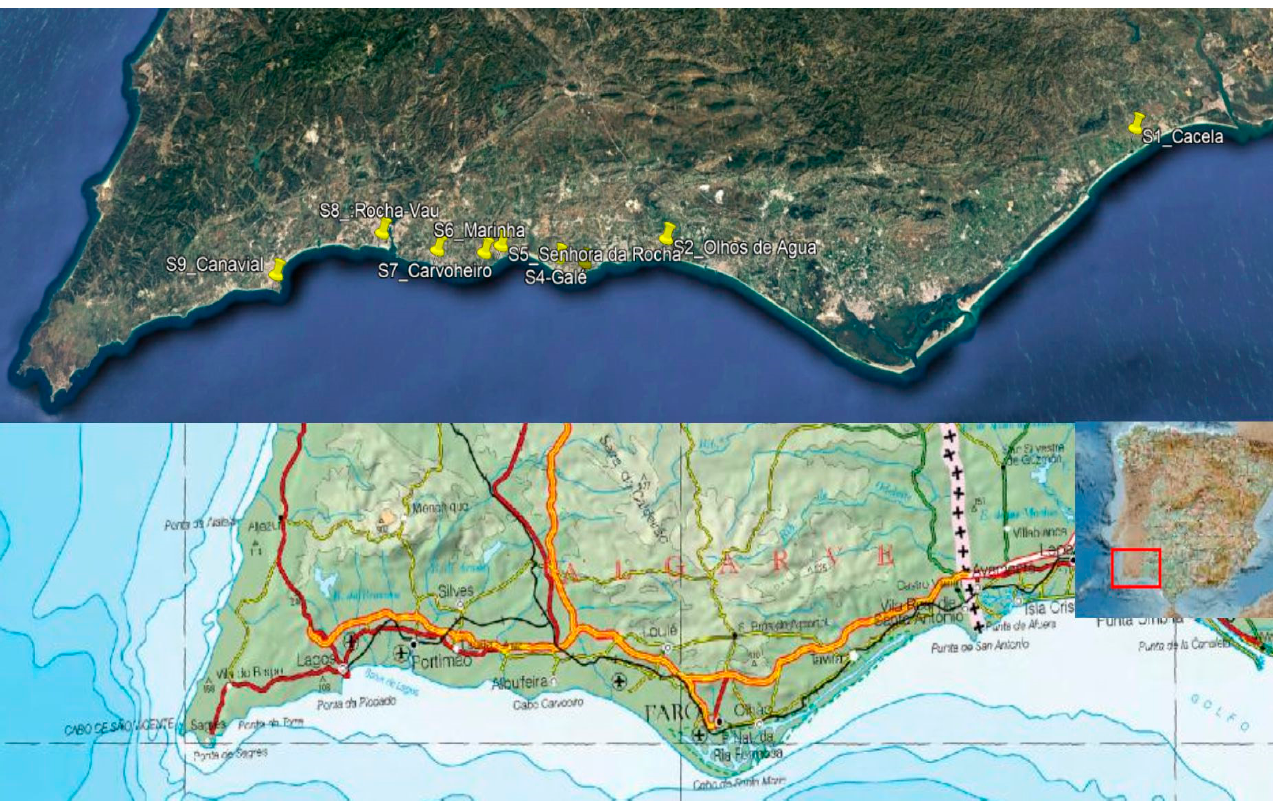
Figure 1. Satellite view and road map of the study area (selected geosites are indicated with yellow mark).